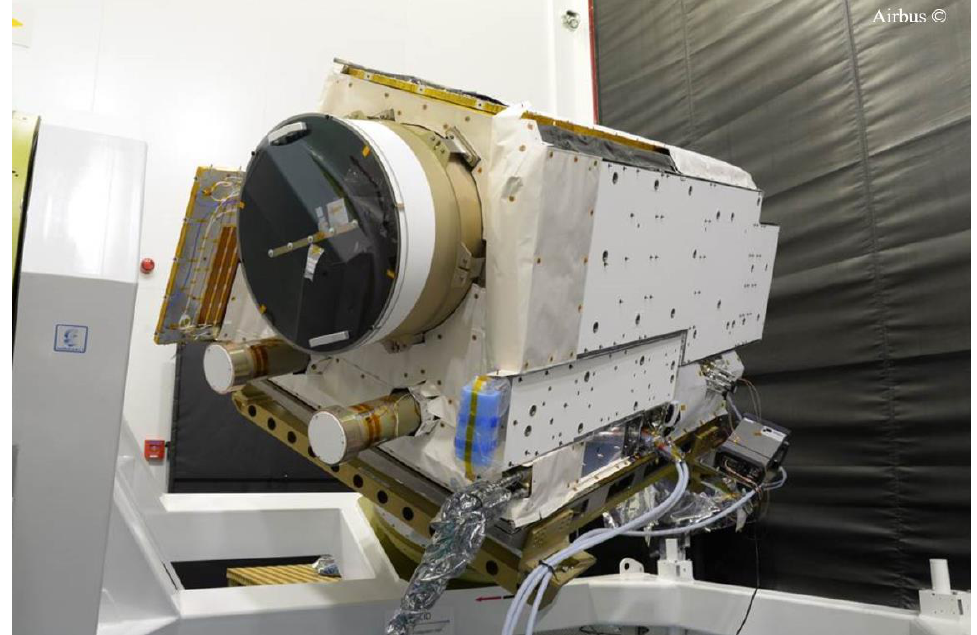
Figure 4. ATLID on trolley after completion of its integration. Reproduced with permission of Airbus © .